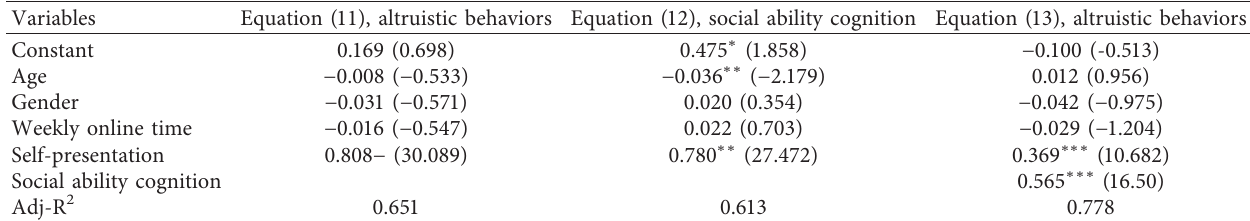
Table 3: Regression results of intermediary effects of social ability